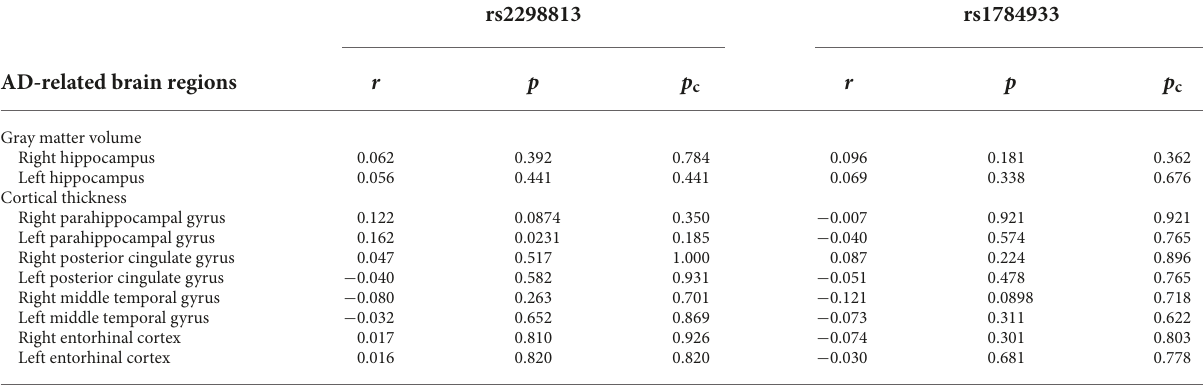
TABLE 2 Associations of homozygous major allele carriers of rs2298813 and rs1784933 with regional cortical thickness/gray matter volume in Alzheimer’s disease (AD)-related brain regions.